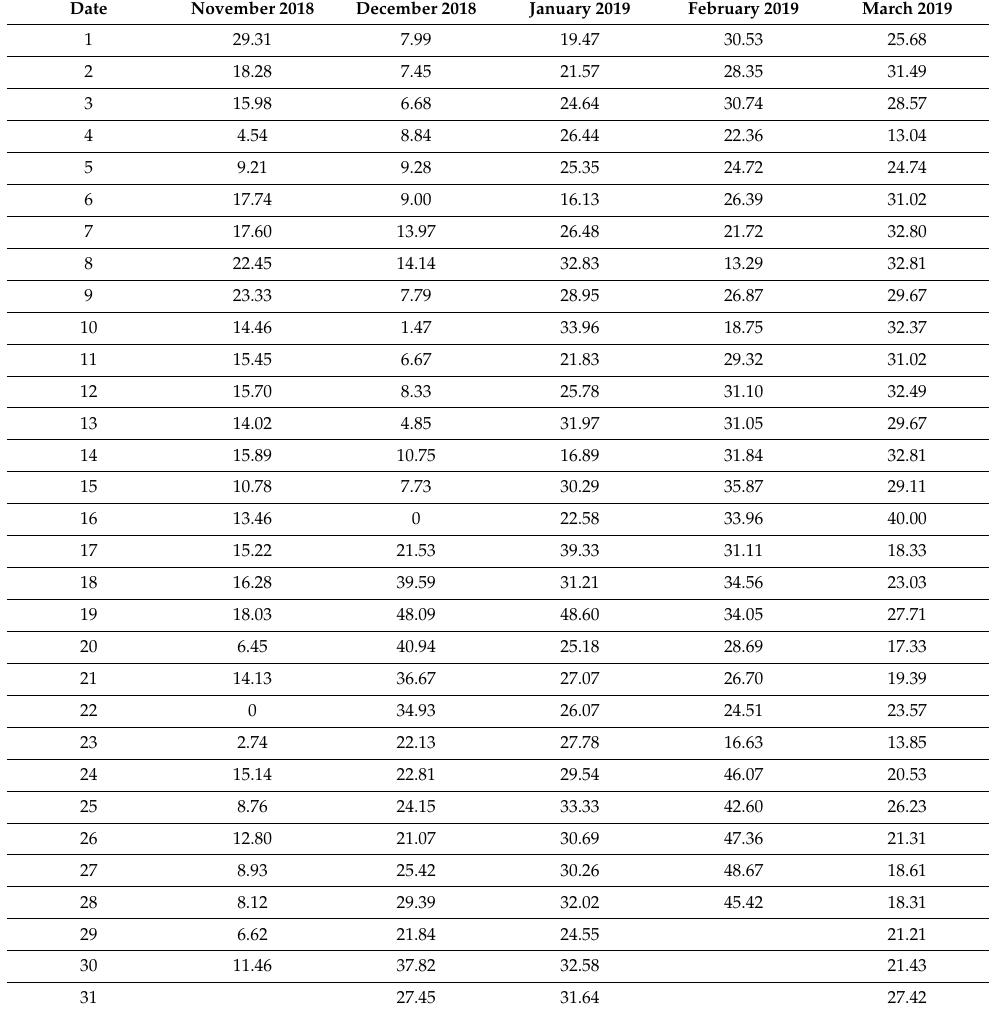
Table 5. Grid Dependency (%) of AG Feeder in a